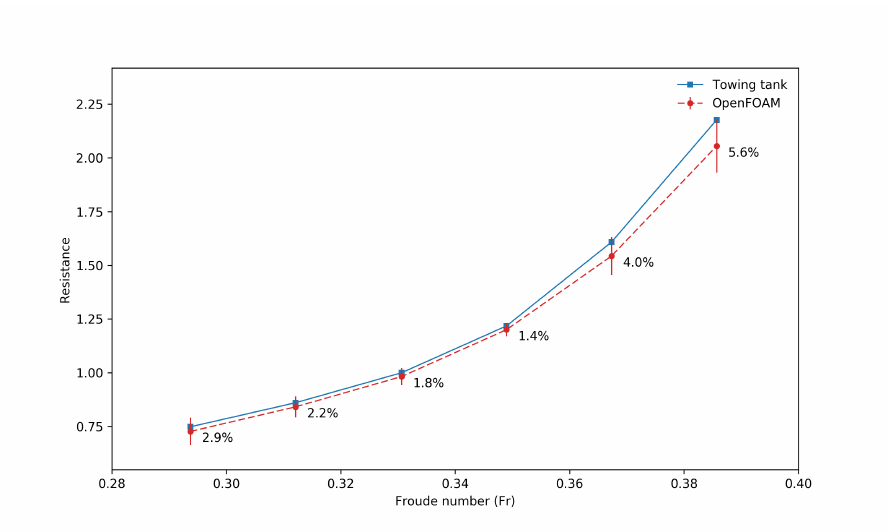
Figure 10. Comparison of the normalized resistance as a function of the Froude number. The numbers next to the markers indicate the percentage error between the numerical results and the experimental